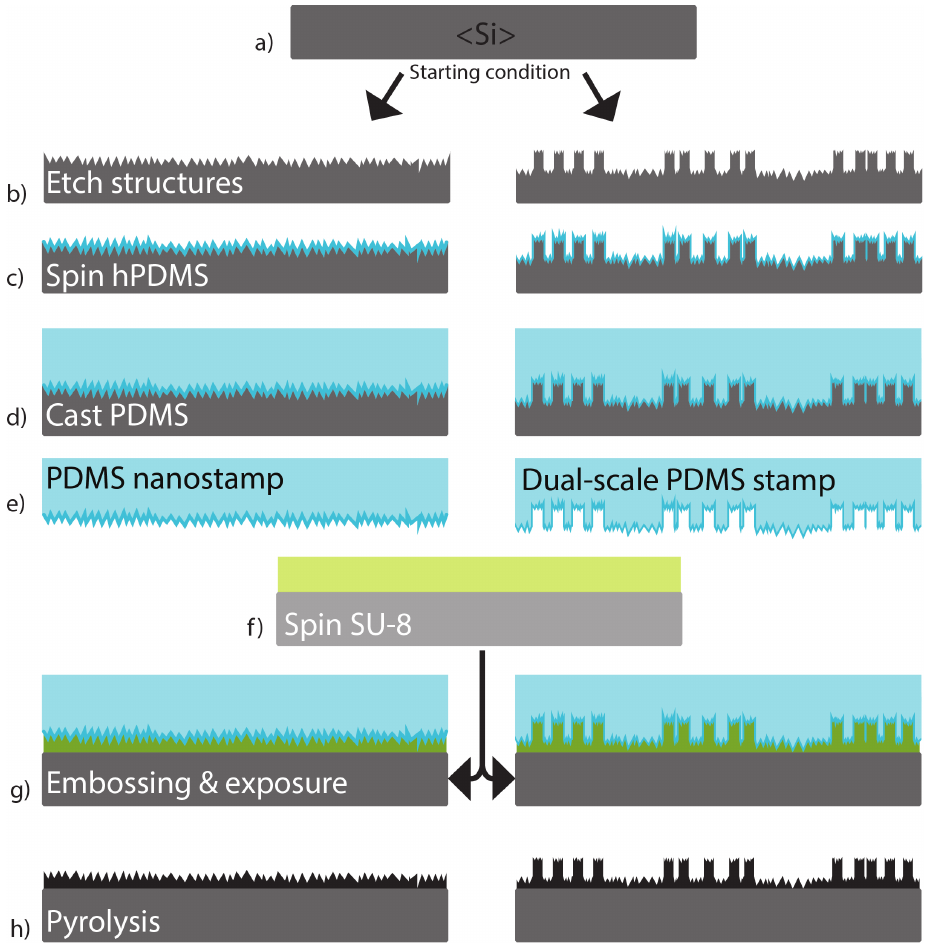
Figure 2. Process flow for pyrolytic carbon micro- and nanotopography fabrication with